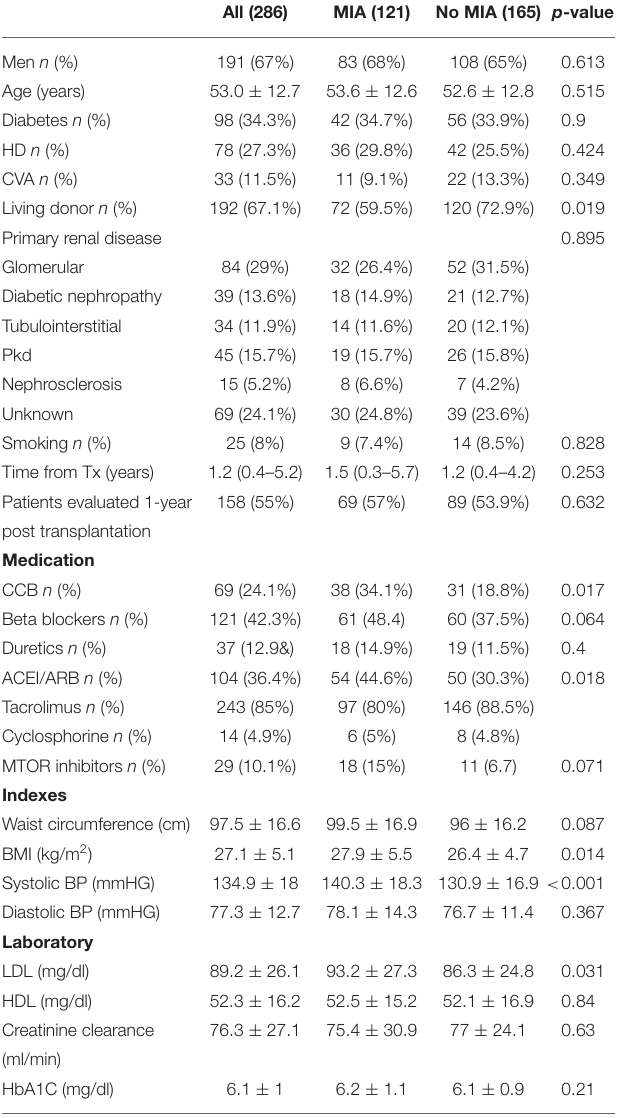
TABLE 1 | Demographic, clinical, transplantation related, and laboratory characteristics of kidney transplanted patients who completed a timed urine